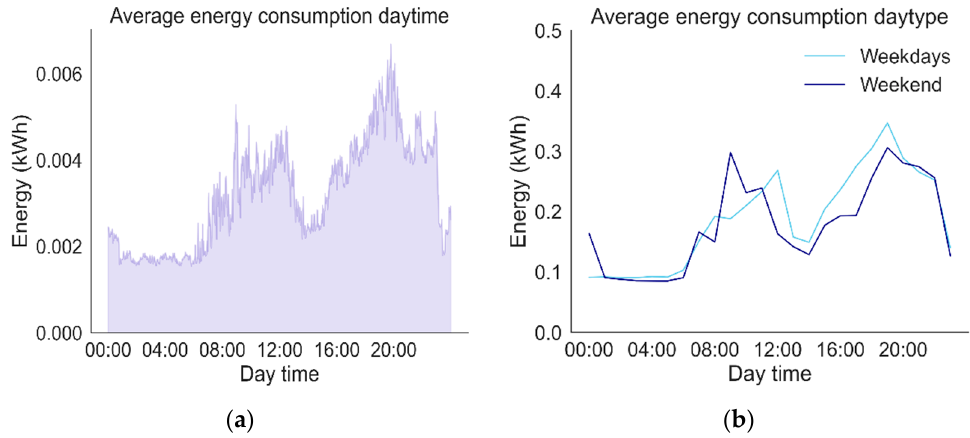
Figure 10. ( a ) Hourly average energy consumption versus time. ( b ) Hourly average energy consumption per weekday type.